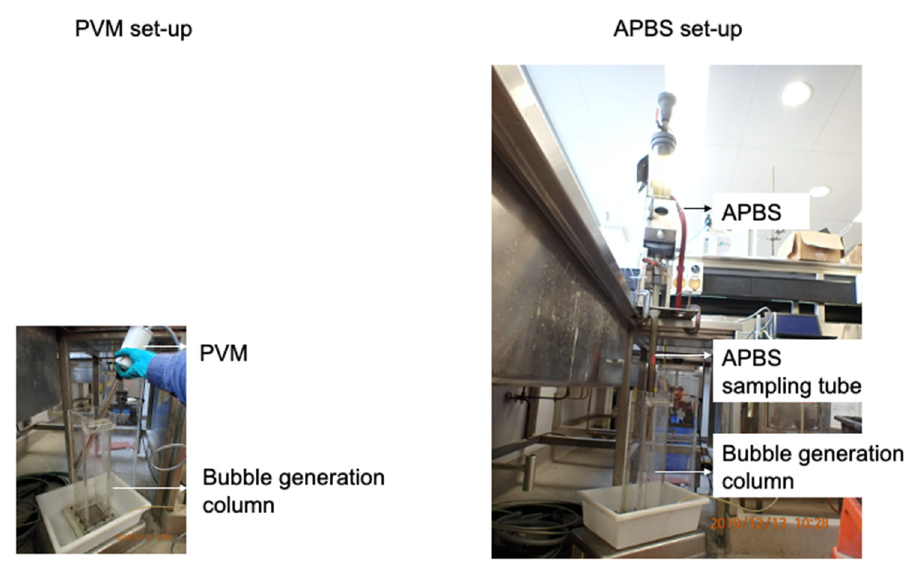
Figure 5. Image processing sequence.